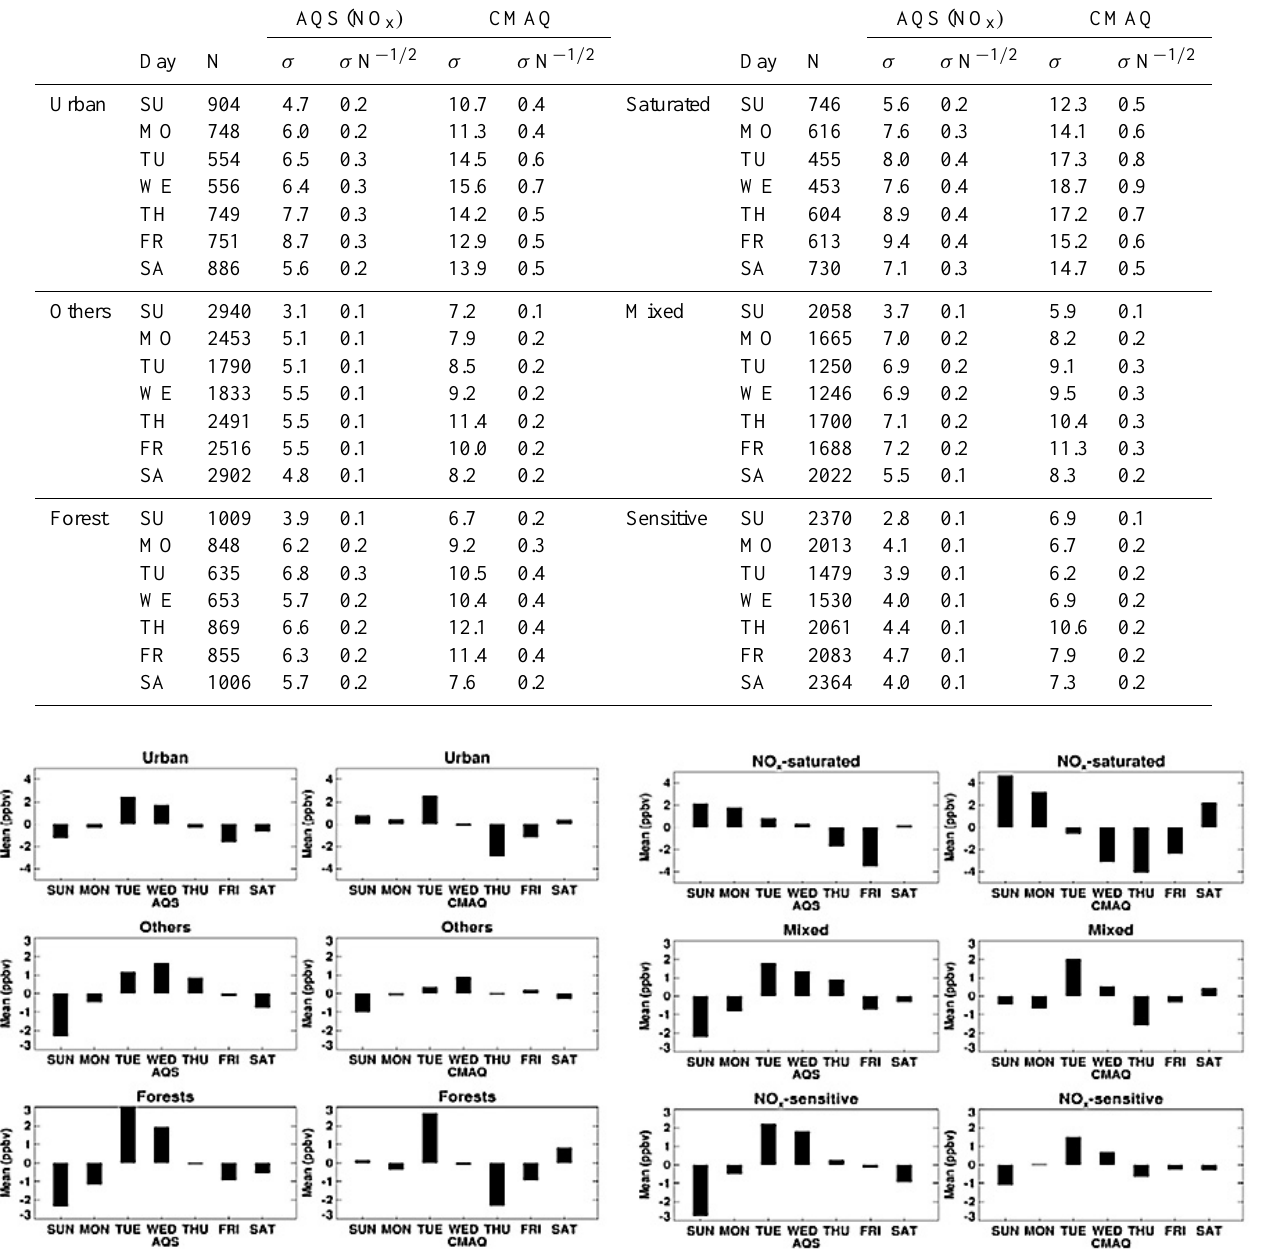
Fig. 7. The same as Fig. 6, but for ground-level O 3